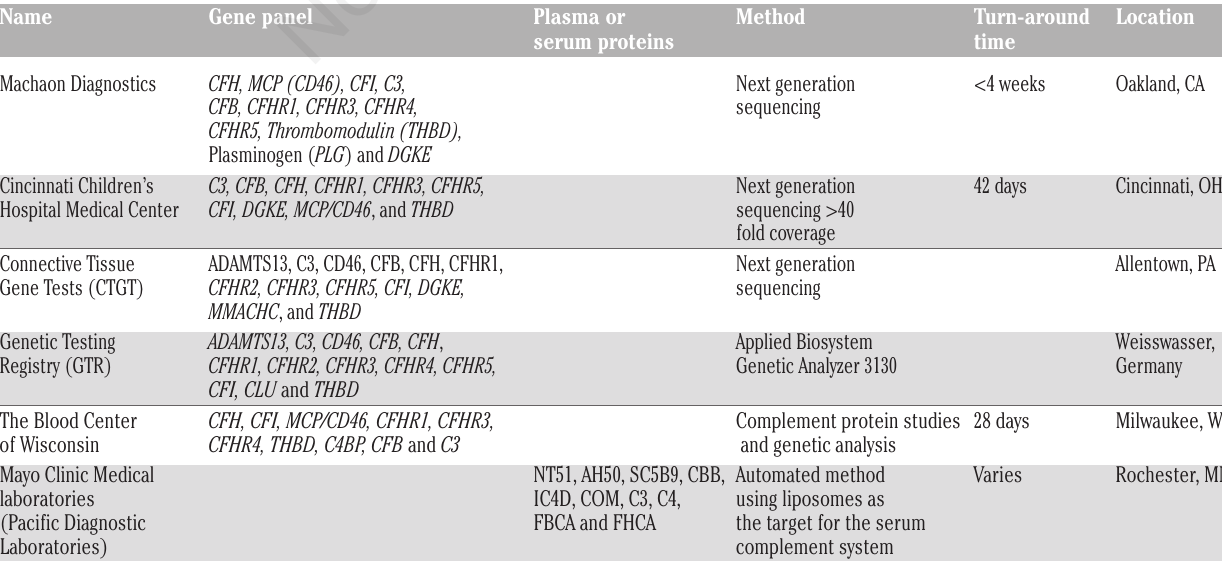
Table 2. Commercially available diagnostic atypical hemolytic uremic syndrome test